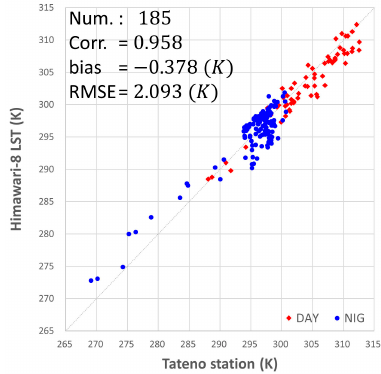
Figure 11. Scatter plot between Himawari-8 LST and Tateno station Baseline Surface Radiation Network LST (red square symbol: daytime; blue circle symbol: nighttime).